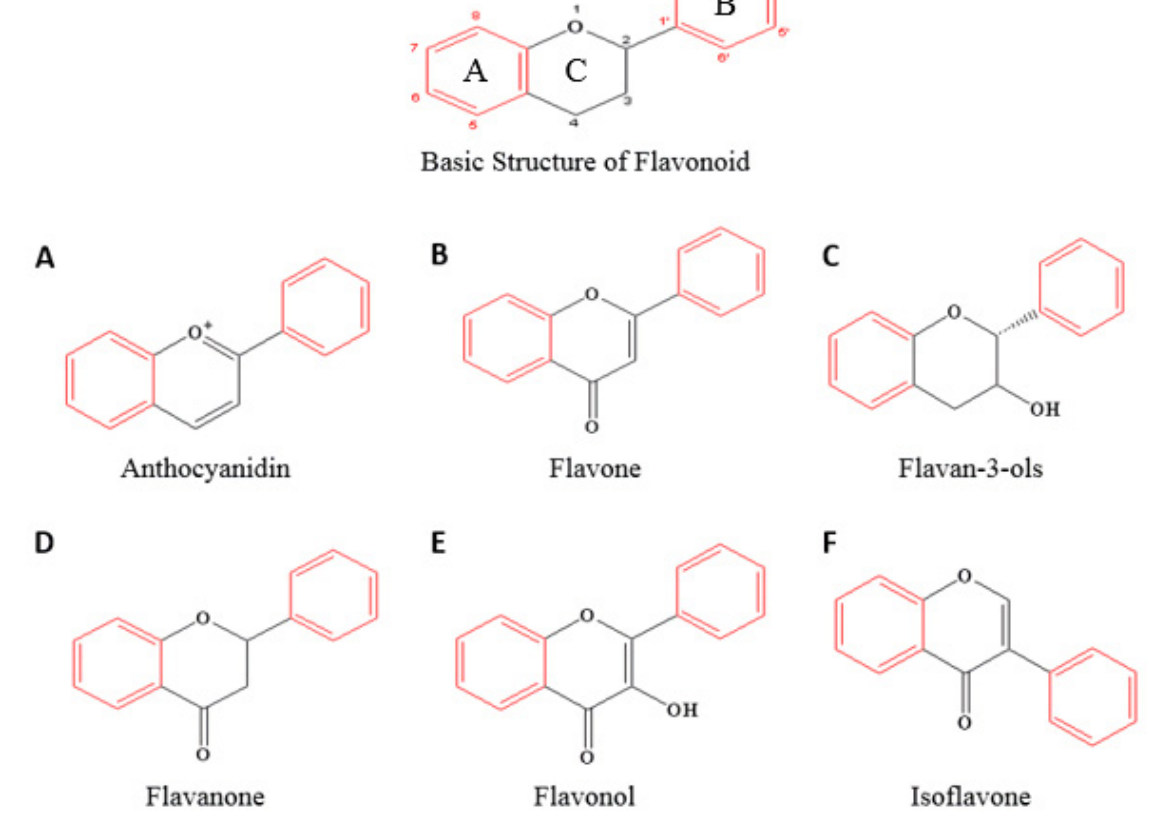
Figure 1. The basic structures and subclasses of flavonoids.